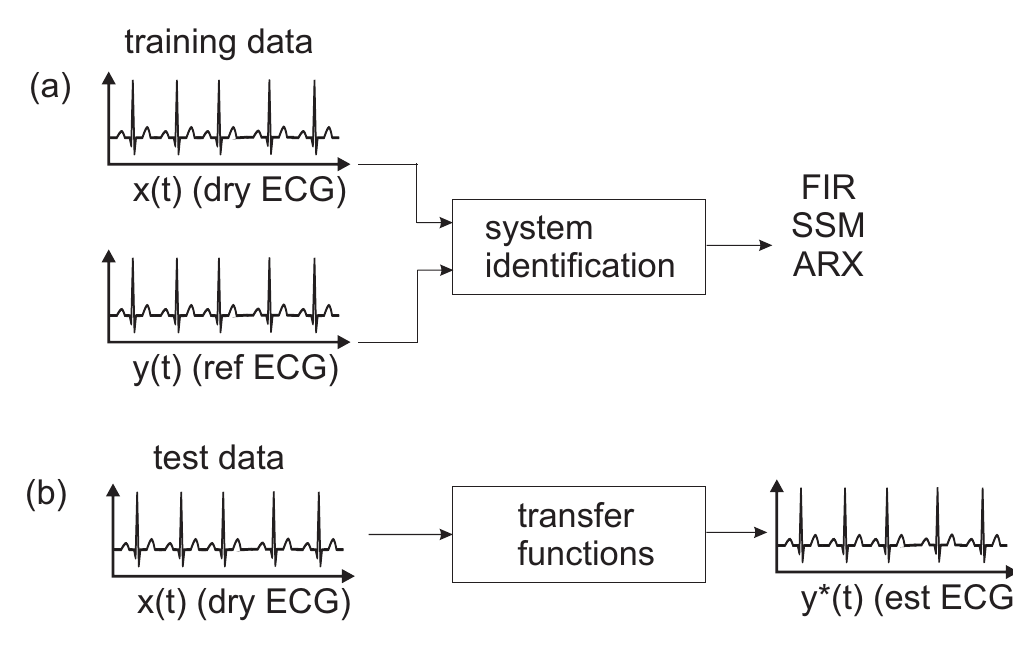
Figure 5. Concept for correction: ( a ) System identification with training data from reference ECG and uECG; ( b ) Application of transfer functions on uECG test